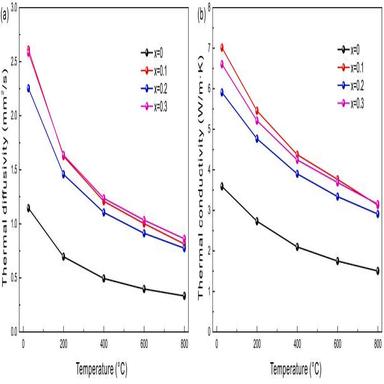
(a) Thermal diffusivities of (Y1-xLax)3Al5O12 (x = 0, 0.1, 0.2, 0.3) samples as a function of temperature, (b) thermal conductivities of (Y1-xLax)3Al5O12 (x = 0, 0.1, 0.2, 0.3) samples as a function of temperature.